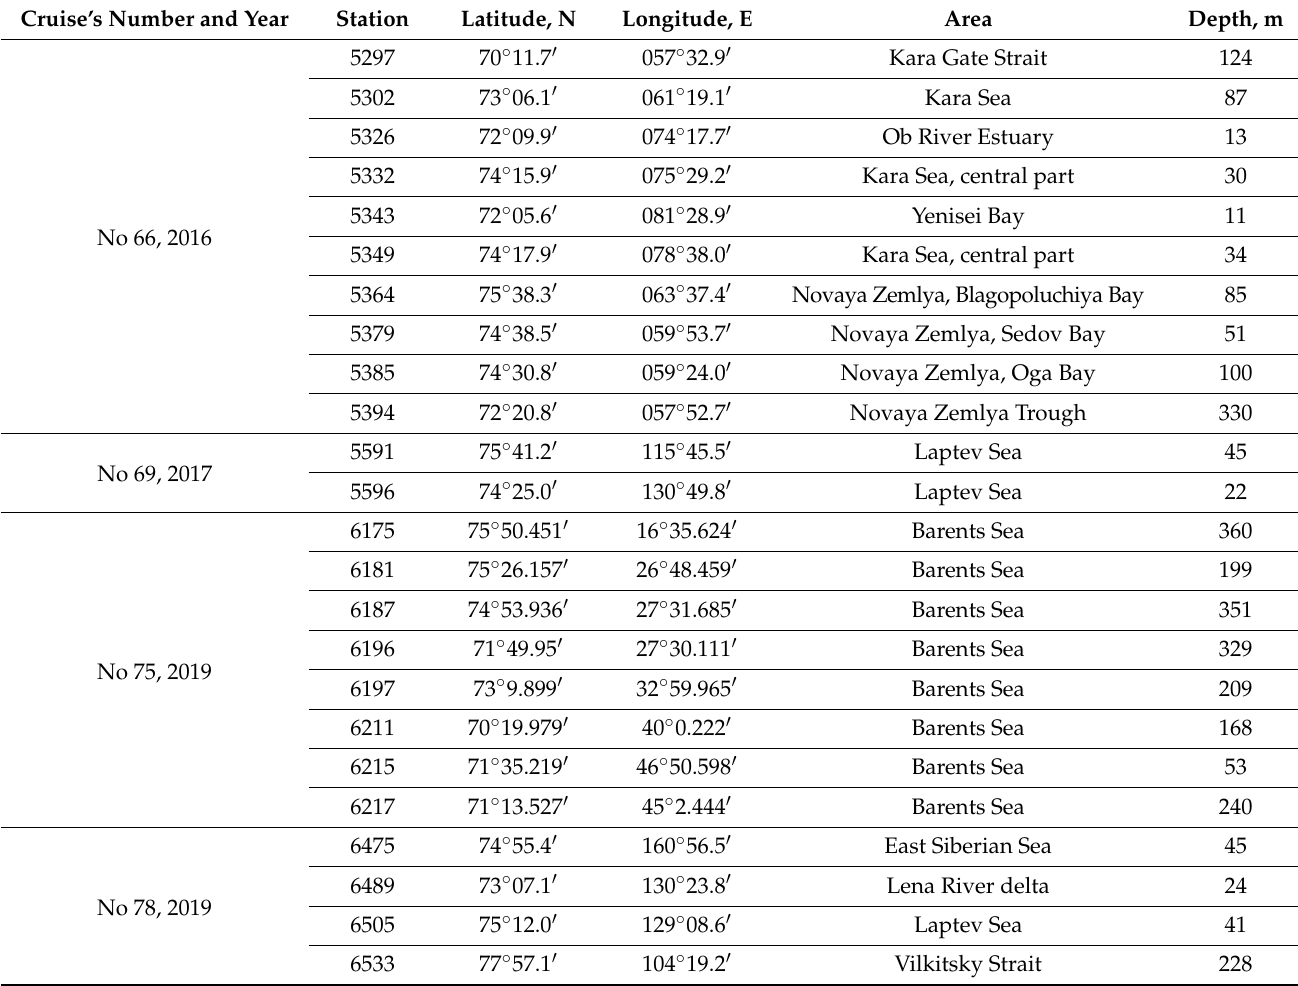
Table 1. Location of the surface bottom sediments sampling (horizon of 0–2 с